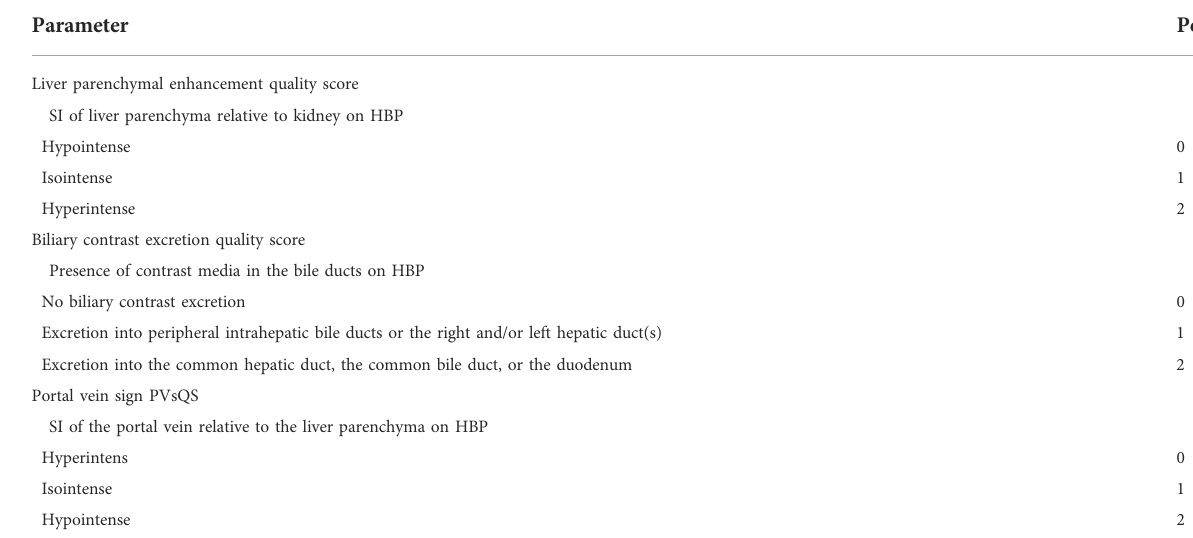
TABLE 2 Defnition and grading system for the three FLIS